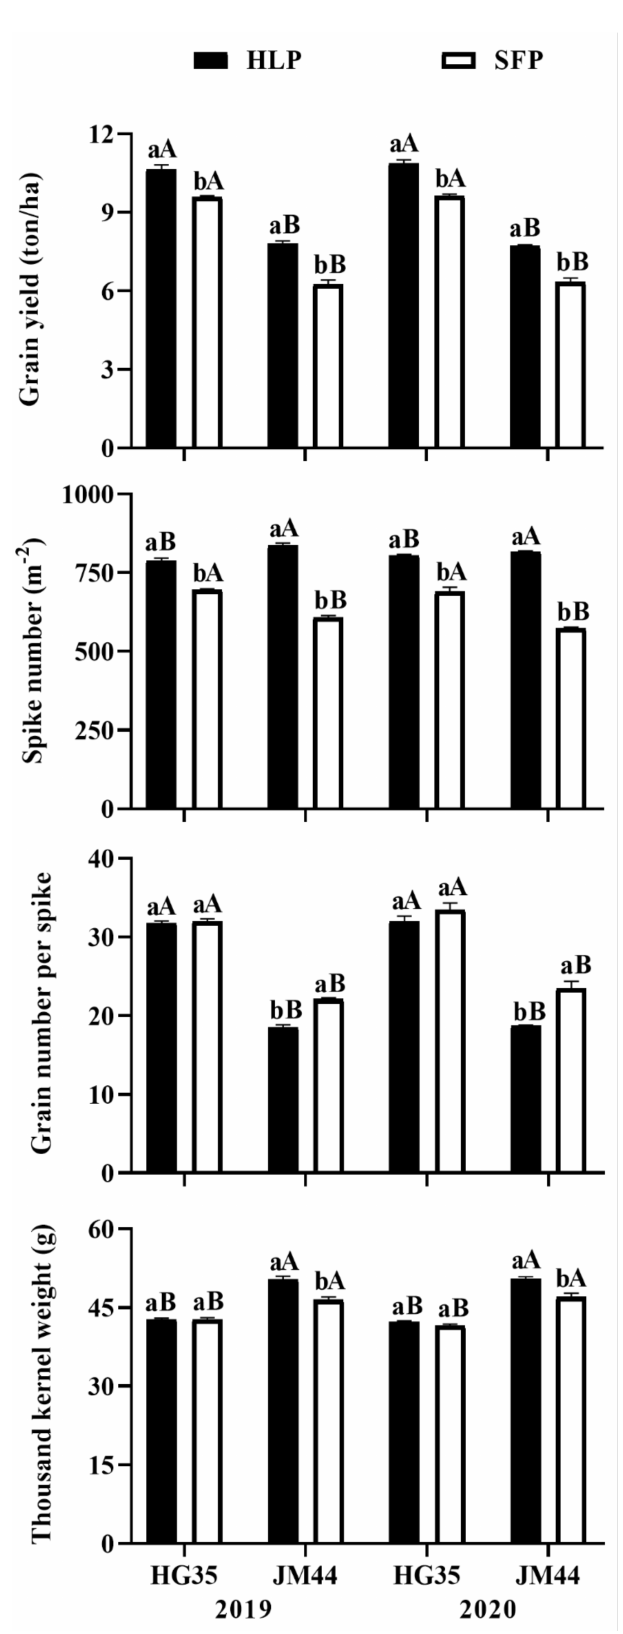
Figure 2. Effects of sowing modes, cultivars, and their interactions on wheat yield and yield compo- nents. HG35: Hengguan 35; JM44: Jimai 44; HLP: high-low-plot sowing mode; SFP: small-flat-plot sowing mode. The same lowercase letters indicate that the difference between sowing modes was not significant. The same uppercase letters mean the difference between cultivars was not